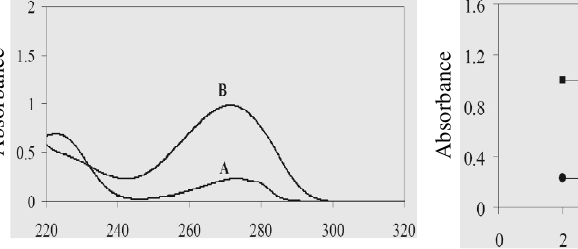
Figure 1. Zero order absorption spectra of (A) 10 µmol L -1 guaifenesin and (B) 10 µmol L -1 theophylline at pH 10.0.